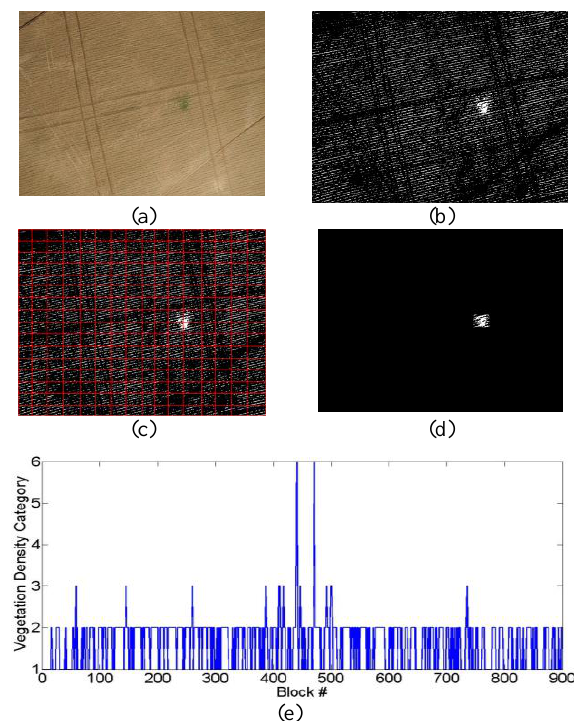
Figure 8. A sample for the achieved results at each step of the methodology. (a): RGB image, (b): vegetation binary image, (c): the grid blocks added to the vegetation image, (d) the weed image, and (e): the vegetation density vs block number